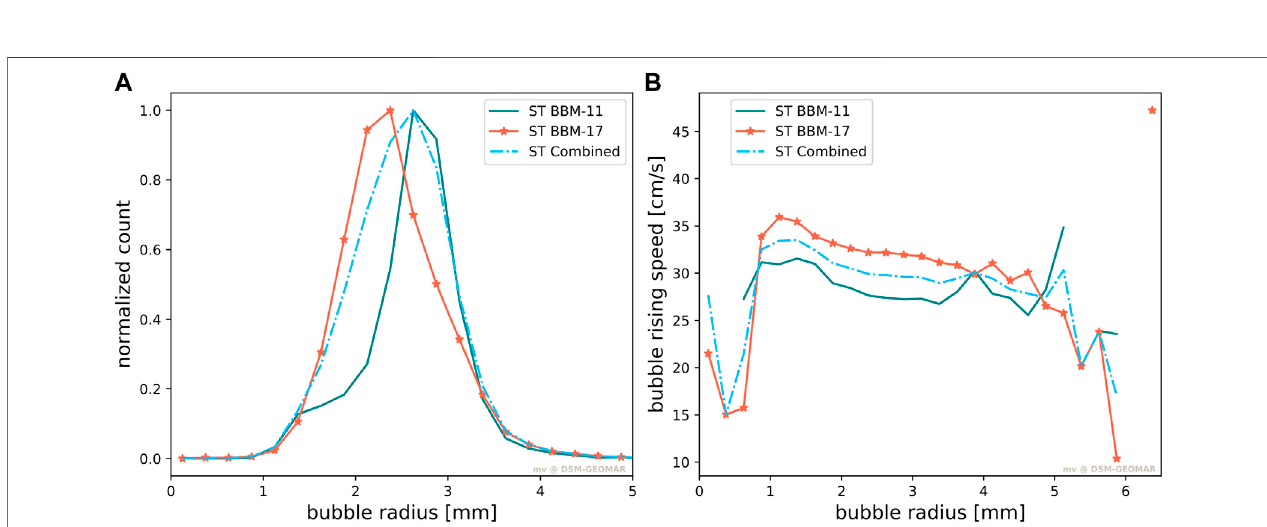
FIGURE5|(A) Normalizedbubblesizedistributions (BSDs)obtainedfromresultsofthestereo-matching approachateach BBMdeployment(STBBM-11andST BBM-17) and the average between them (ST Combined). (B) Bubble rising speeds in function of the radius generated from the results of the stereo-matching approach (ST BBM-11 and ST BBM-17) and the average between them (ST Combined).